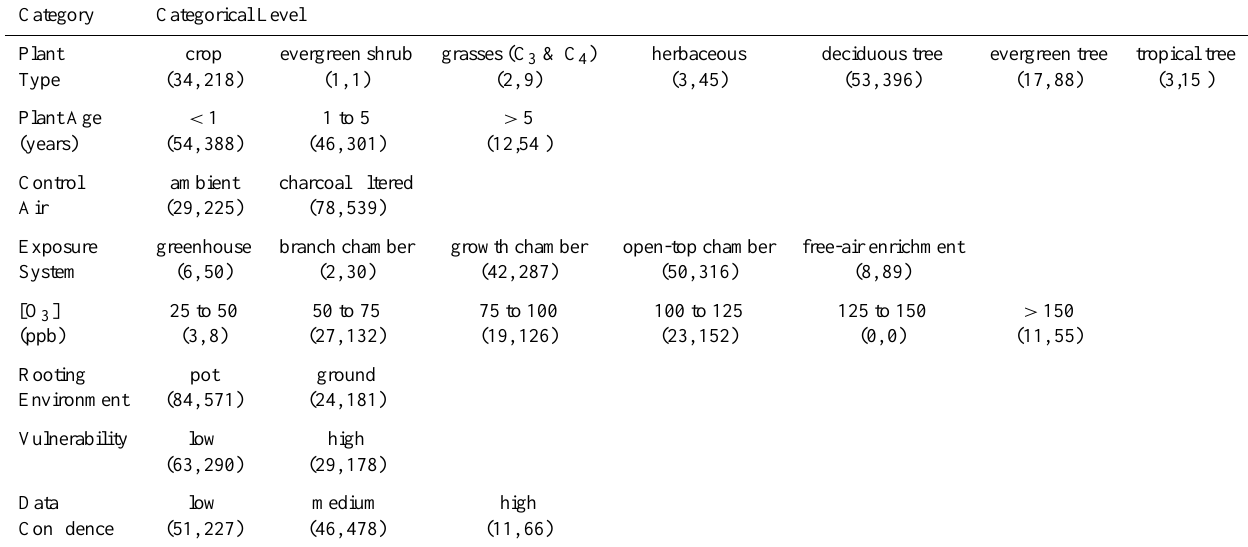
Table 1. Categories and levels describing the data collected from experiments studying O 3 effects on photosynthesis and stomatal conduc- tance. Each row shows a category and the columns show various levels of that category. All tree categories are temperate unless otherwise noted. Numbers in parentheses are the number of studies and the number of data points within the associated categorical level: (# of studies, n ).